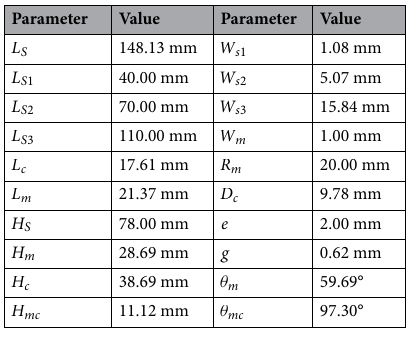
Table 1. Detailed parameters of the antenna design.